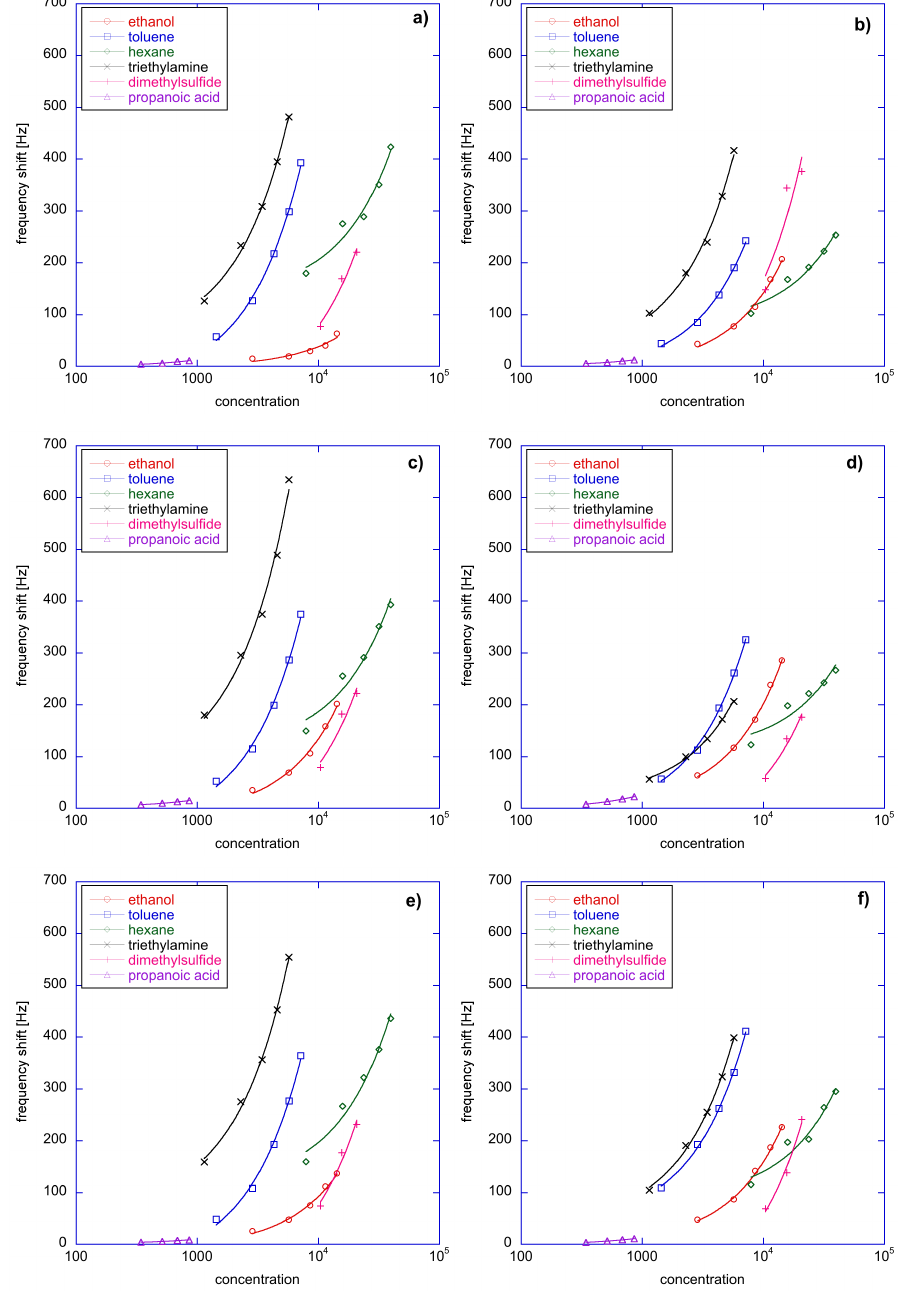
Figure 2. Response curves of each sensor vs. the concentration of test VOCs: ( a ) CuTPP; ( b ) CoTPP, ( c ) ZnTPP; ( d ) MnTPPCl; ( e ) FeTPPCl; ( f ) SnTPPCl2. In order to accommodate the wide range of concentration, the x axis is plotted in logarithmic scale. Linear fits, drawn as a continuous line, appears